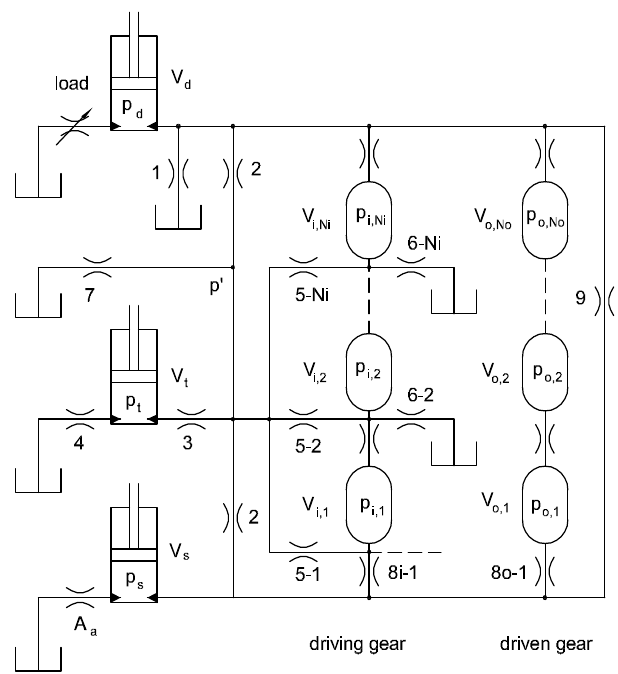
Figure 4. Hydraulic scheme of the pump with the indication of all possible flow paths.